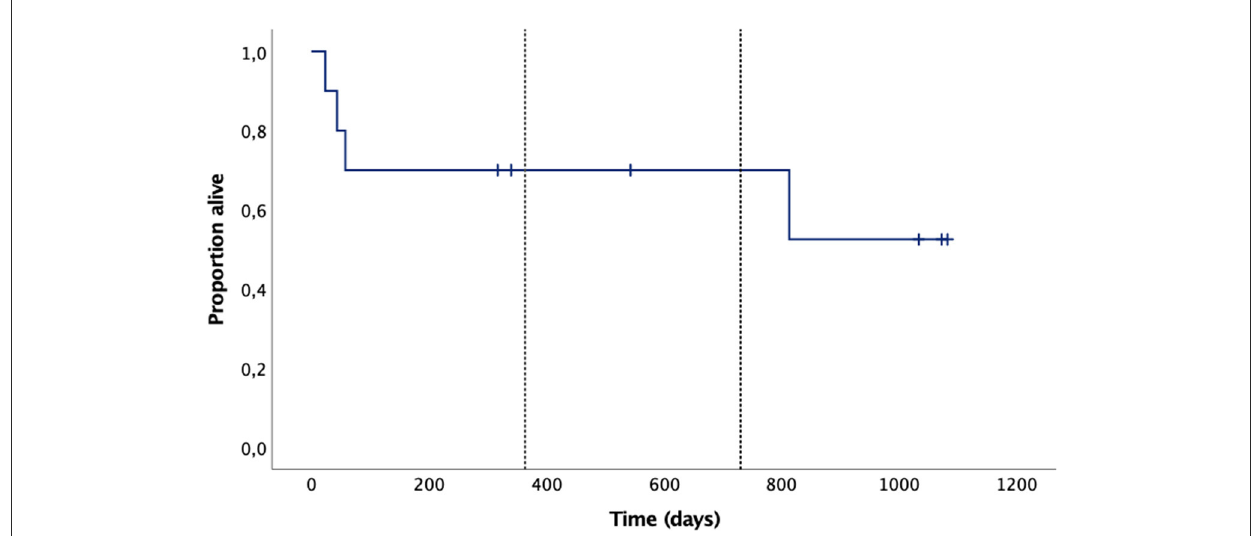
FIGURE5 Overall survival Kaplan-Meier curves of the 10 dogs: mean overall survival was 723 days (95%CI: 436–1,011), median not reached. The tick marks represent censored cases, the vertical dotted lines mark 1 and 2 years.